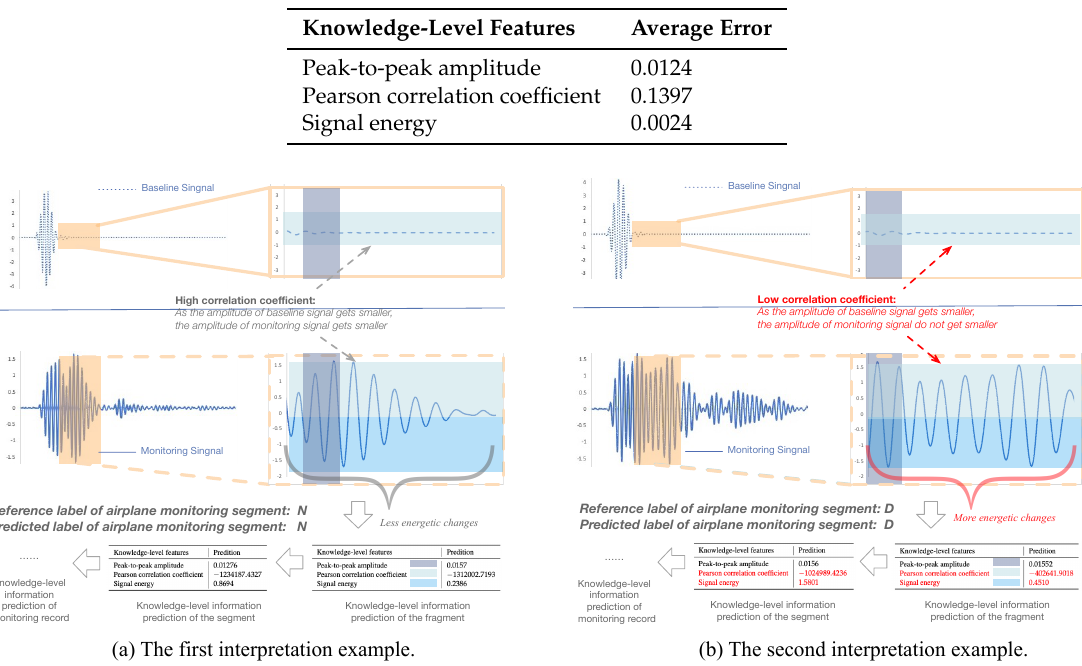
Figure 9. Case studies of prediction interpretation on the Aircraft Monitoring